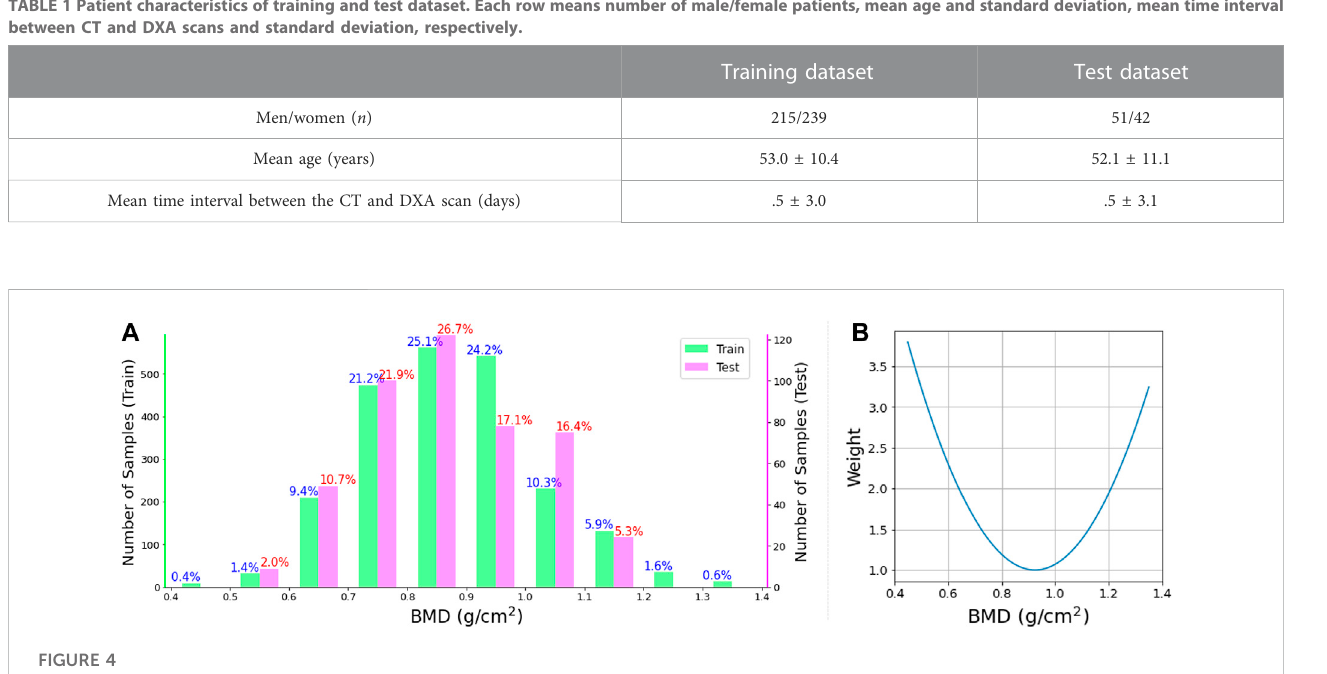
FIGURE 4 (A) HistogramofBMD.Theleftandrightverticalaxesdenotethenumbers(frequencies)oftrainingsamplesandtestsamples,respectively.Thehorizontal axis denotes BMD and the bin width is .1. The number above every bar represents the percentage ratio. (B) Weight w used for the loss function in Eq. 1. The weight curve over BMD is associated with the inverse of the curve fi tting to the distribution of training samples in the